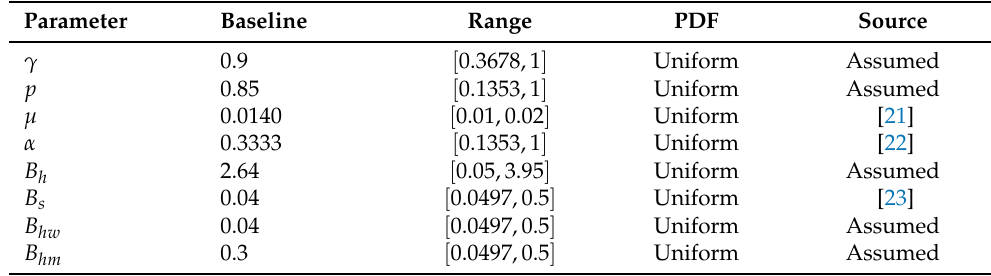
Table 2. Parameters used in Sensitivity Analysis through Latin Hypercube Sampling and Partial Rank Correlation Coefficients